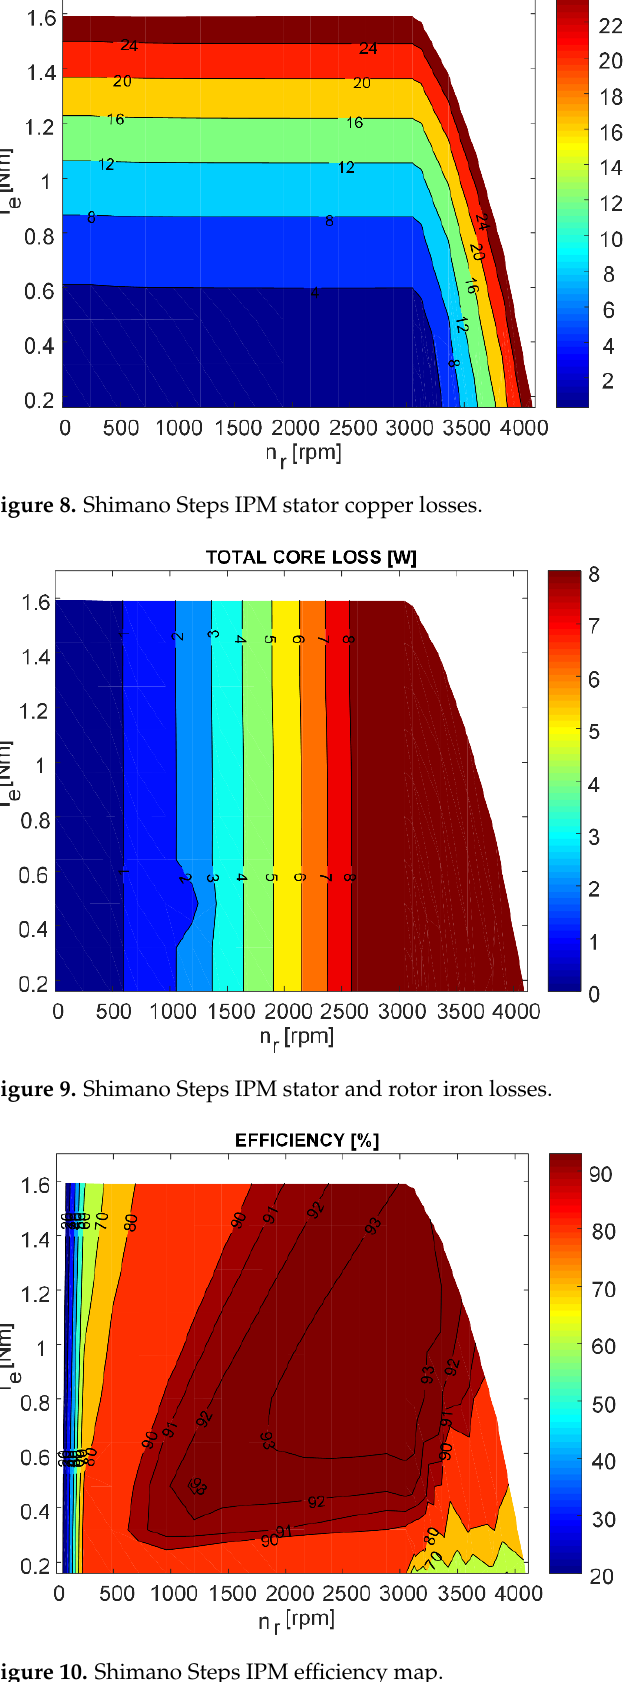
Figure 10. Shimano Steps IPM efficiency map.